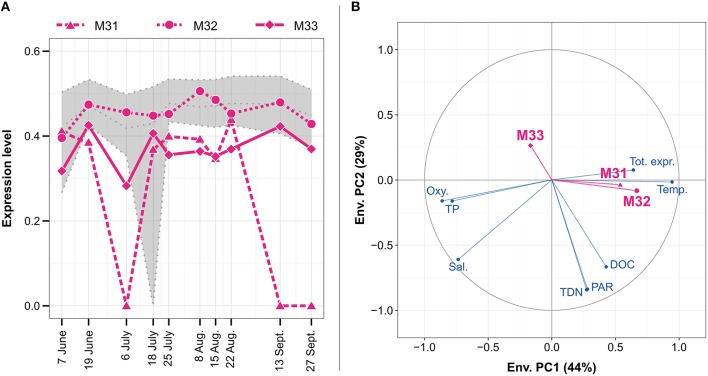
Expression patterns for the three Nodularia spumigena metacaspase genes M31–M33 (A) and their correlation to environmental variables (B) during the Askö 2012 time series (Phase III; 10 samples, June–September). The expression level (A) is given in inverse hyperbolic sine transformed RPKM values divided by the maximum in each sample. The gray dotted lines represent, from top to bottom, the upper quartile, median and lower quartile of the expression level of N. spumigena genes. The circle of correlations (B) shows Pearson correlation coefficients between the environmental variables (blue) or metacaspase expression patterns (magenta) and the first two principal components of the scaled and PCA-transformed environmental data (see also Figure S2). The proportion of the variance that is explained by each principal component is shown in parentheses in the axis titles. The environmental variables are water temperature (Temp.), oxygen (Oxy.), salinity (Sal.), dissolved organic carbon (DOC), total dissolved nitrogen (TDN), total phosphate (TP), photosynthetically active radiation (PAR), and total expression of N. spumigena relative to all mRNA (Tot. expr.).